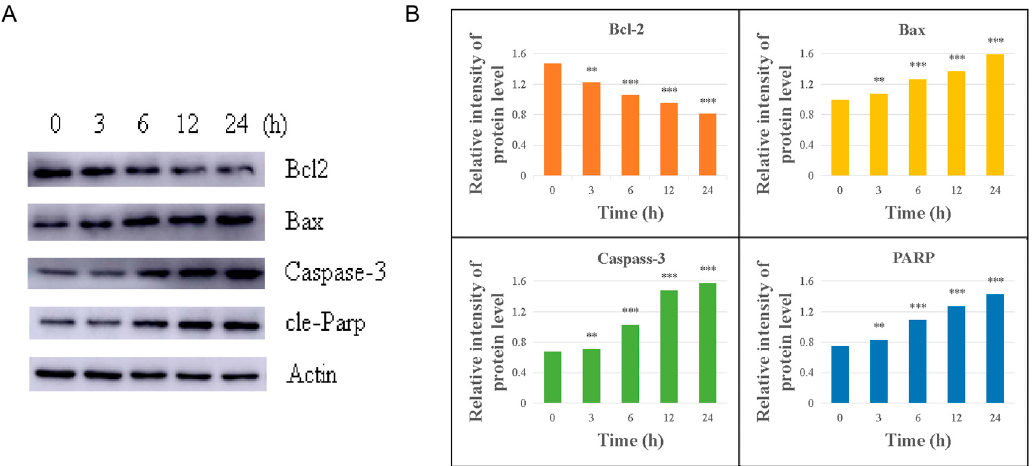
Figure 4. Apoptotic effects of 4f on HeLa cells. ( A ) The effect of compound 4f on the expression levels of Bax, Bcl-2, Caspase 3, and cle-PARP in HeLa cells was analyzed using Western blotting. ( B ) Densitometric quantification. * p < 0.05, ** p < 0.01, and *** p < 0.001 relative to the control group (0 h). Bcl-2, B-cell lymphoma 2; Bax, Bcl-2-associated agonist of cell death; cle-PARP, cleaved poly ADP- ribose polymerase.